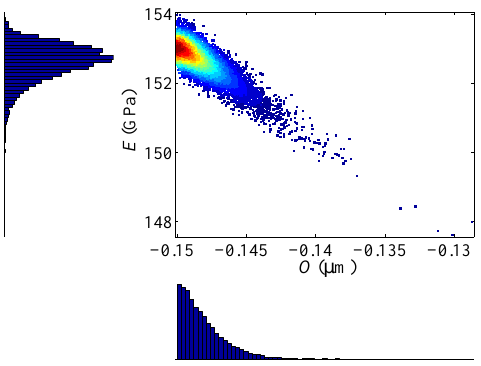
Figure 8. Scattering of the TMCMC samples, and corresponding histograms of the model parameter distributions for device